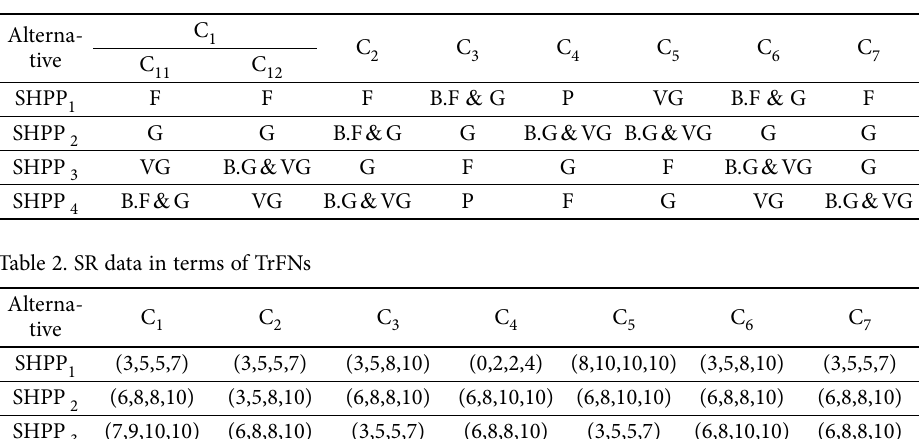
Table 1. Evaluation of SHPPs